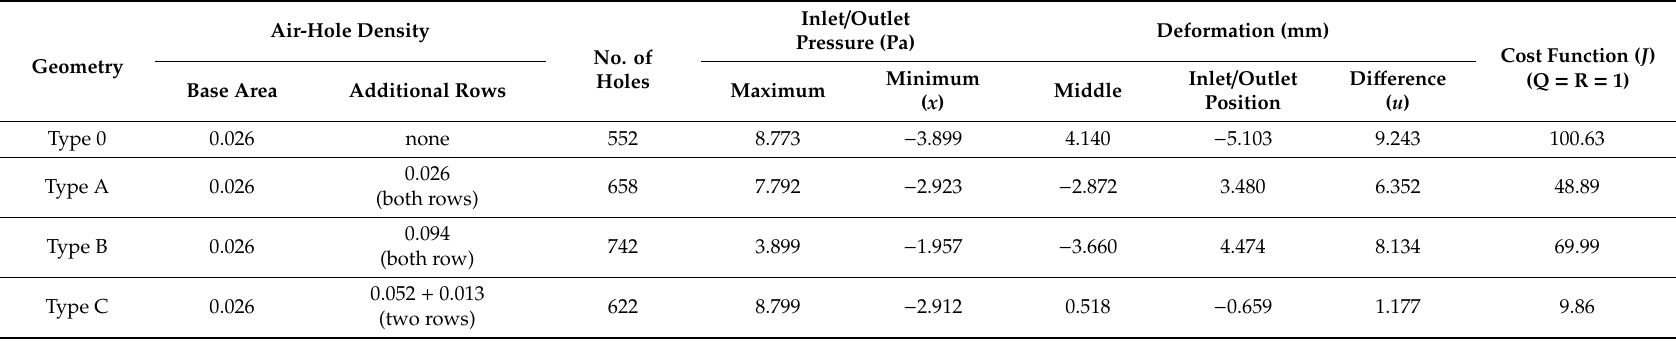
Table 1. Results of the PSI simulations of the pneumatic pressure and deformation of the substrate in the side and middle areas as a function of the air-hole density.